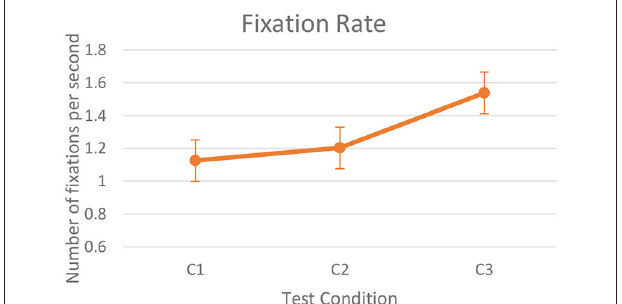
FIGURE 5 | Median power of different EEG bands. TABLE 11 | Statistical test results indicating changes in cognitive workload.